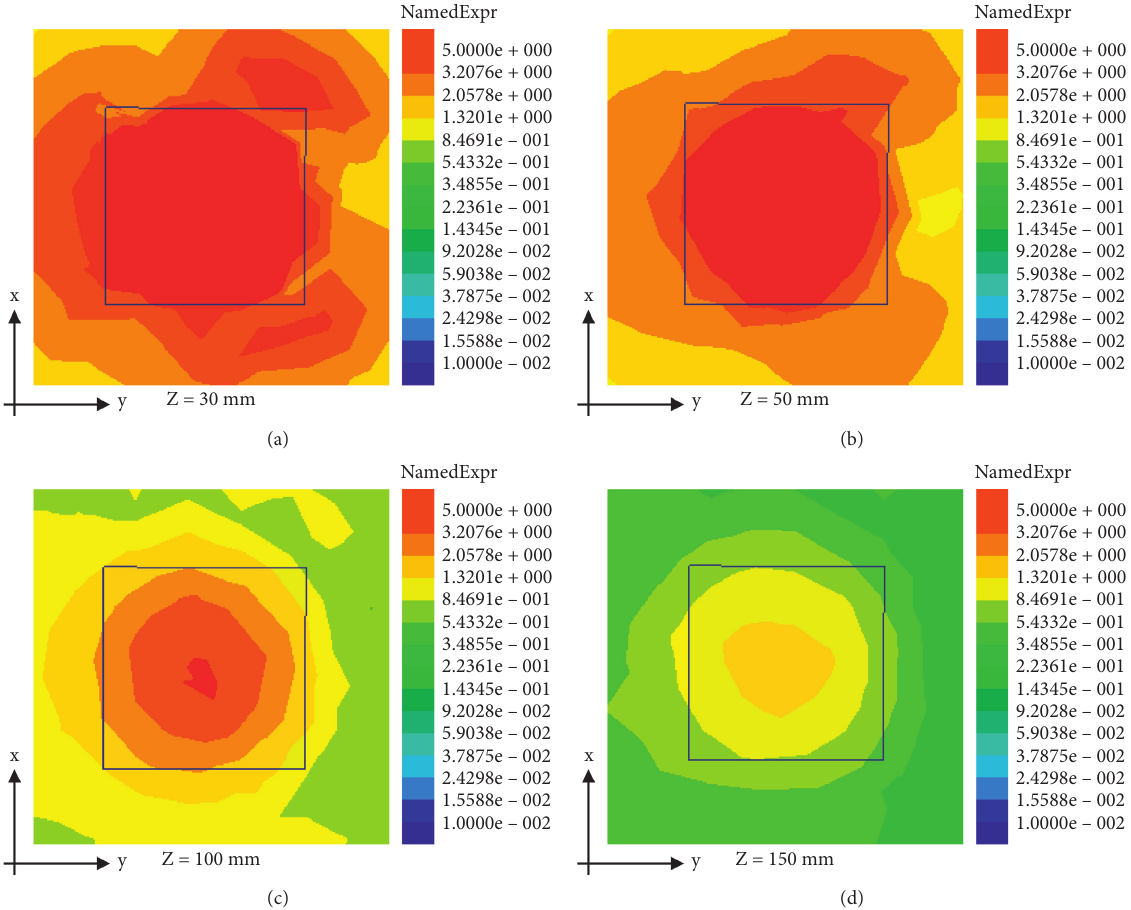
Figure 16: Simulated Ez distributions of the three-branch antenna at different heights when the substrate thickness h � 3.5mm.